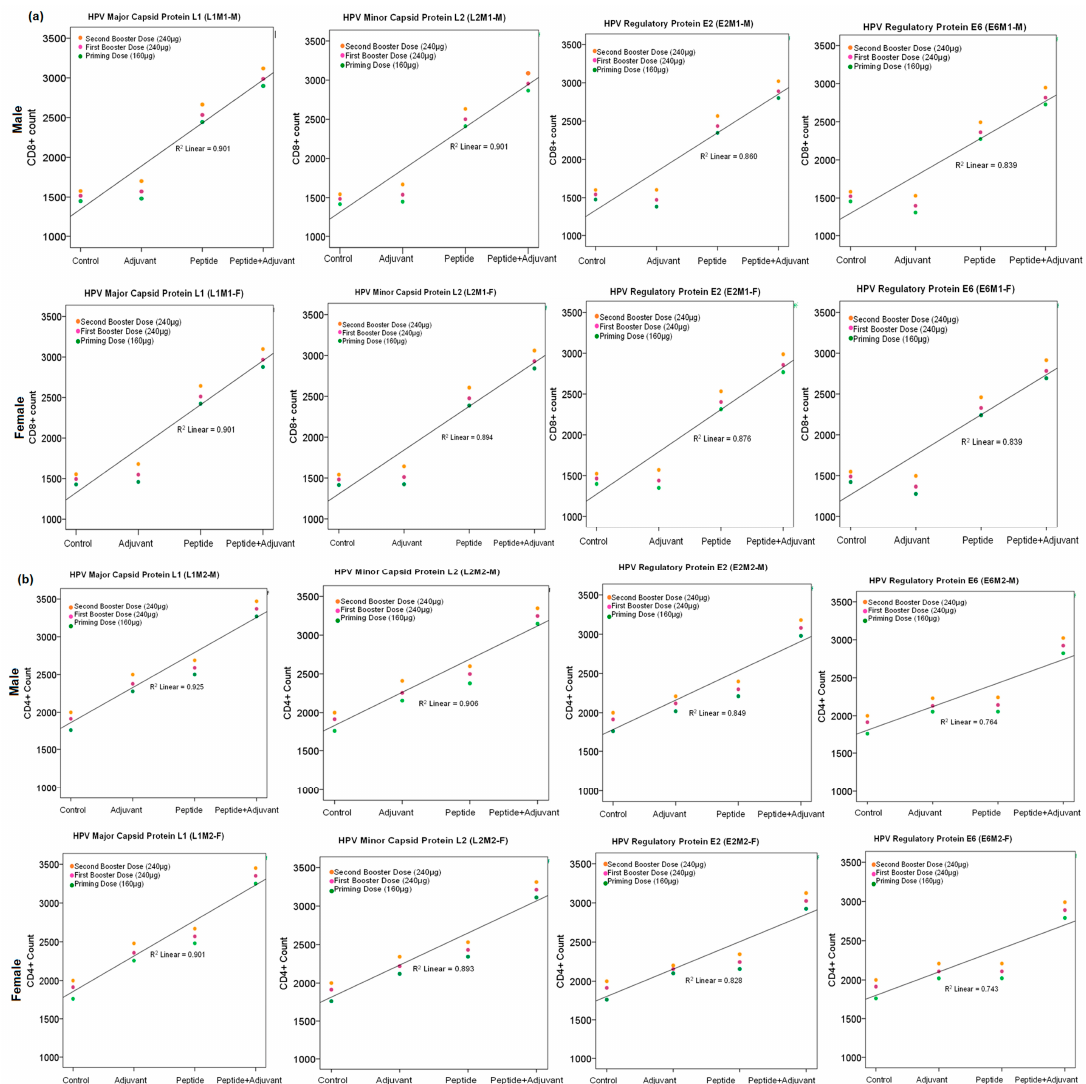
Figure 7. Line graphs expressing CD4+ and CD8+ T cells derived from rats immunized with ( a ) MHC class-I and ( b ) Class-II potential monovalent epitopes (individual peptides) with and without adjuvant at primary, first and second booster doses (R 2 > 0.7). All data were compared to control group.